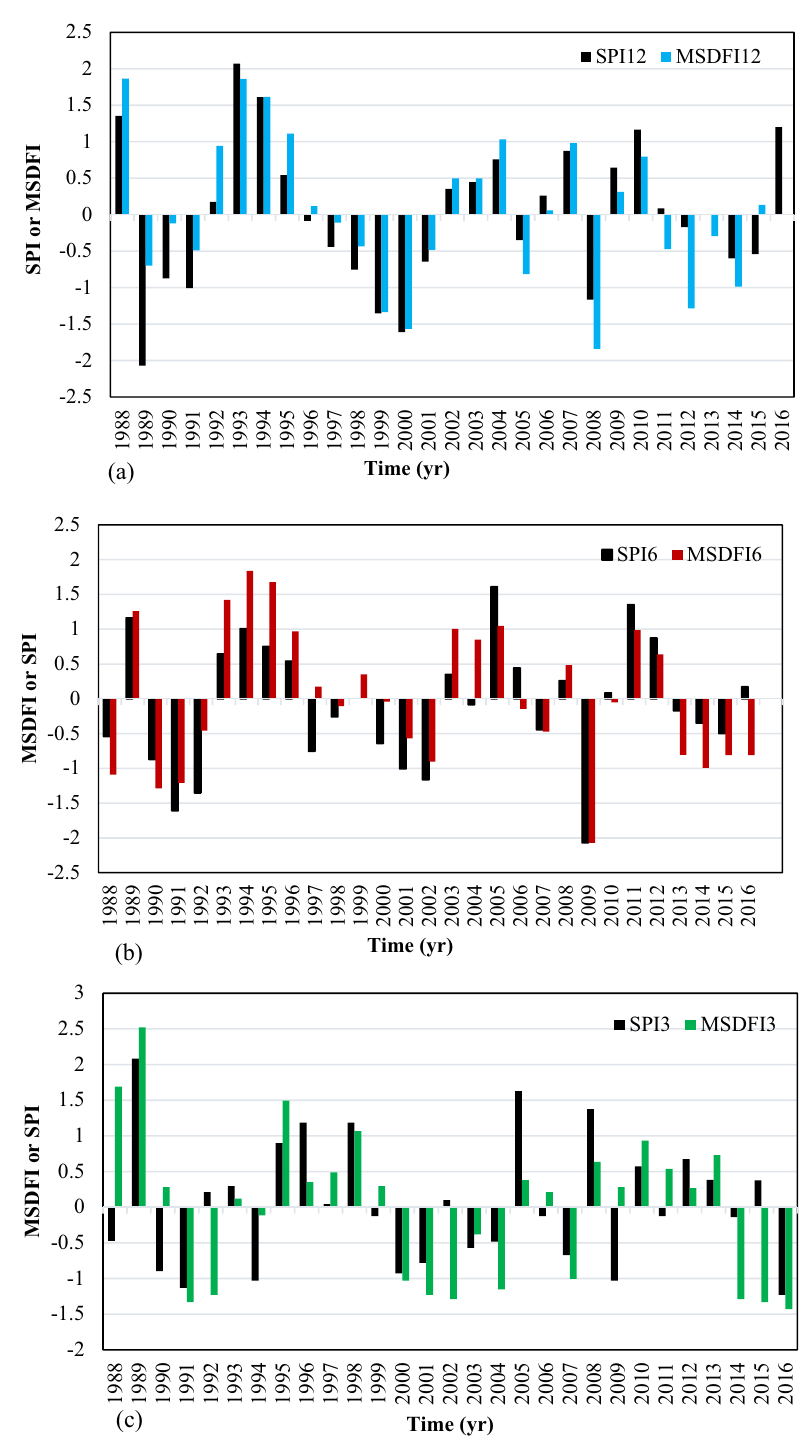
Figure 6. SPI and MSDFI histogram for aggregated ( a ) 12 months ended in September, ( b ) 6 months ended in March, and ( c ) 3 months ended in June in